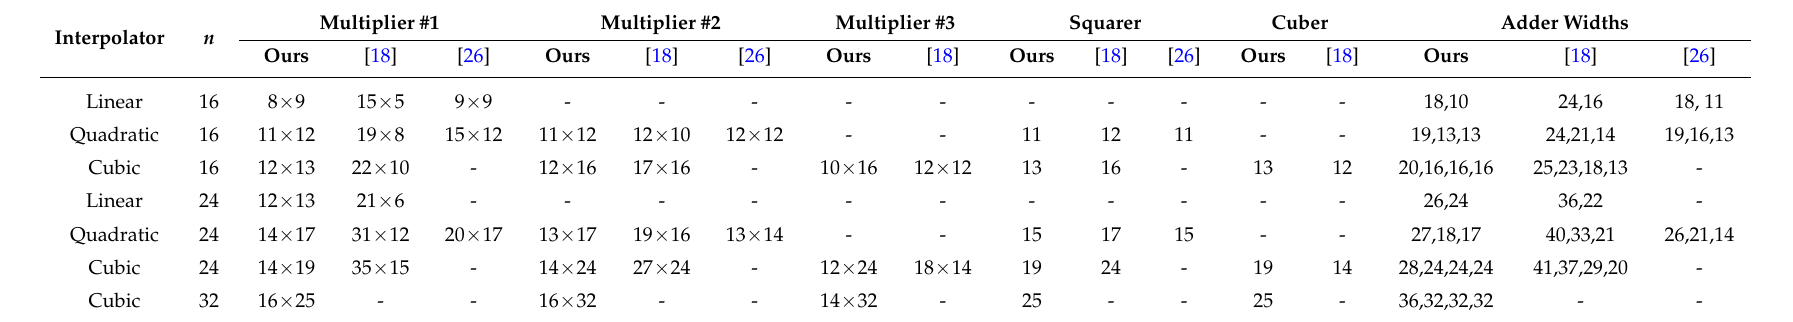
Table 3. Arithmetic units required for faithfully rounded results, f ( x ) = 1/ x .